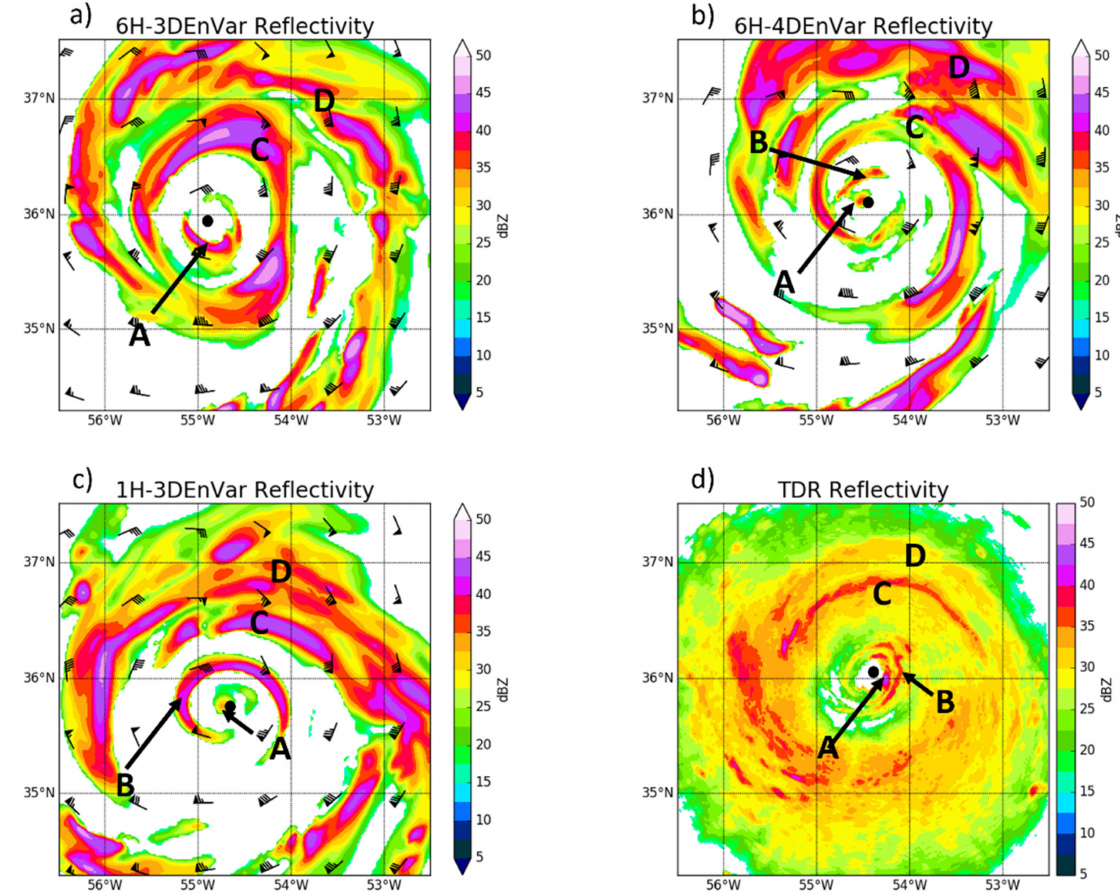
Figure 5. Simulated radar reflectivity valid 1200 UTC 17 September for ( a ) 6H-3DEnVar, ( b ) 6H-4DEnVar from forecast launched 1800 UTC 16 September and, ( c ) 1H-3DEnVar from forecast launched at 2100 UTC 16 September (E3) ( d ) and observed TDR reflectivity valid at 1312 17 UTC September. A and B are structures within the inner eyewall, C marks the secondary eyewall, and the rainband marked with